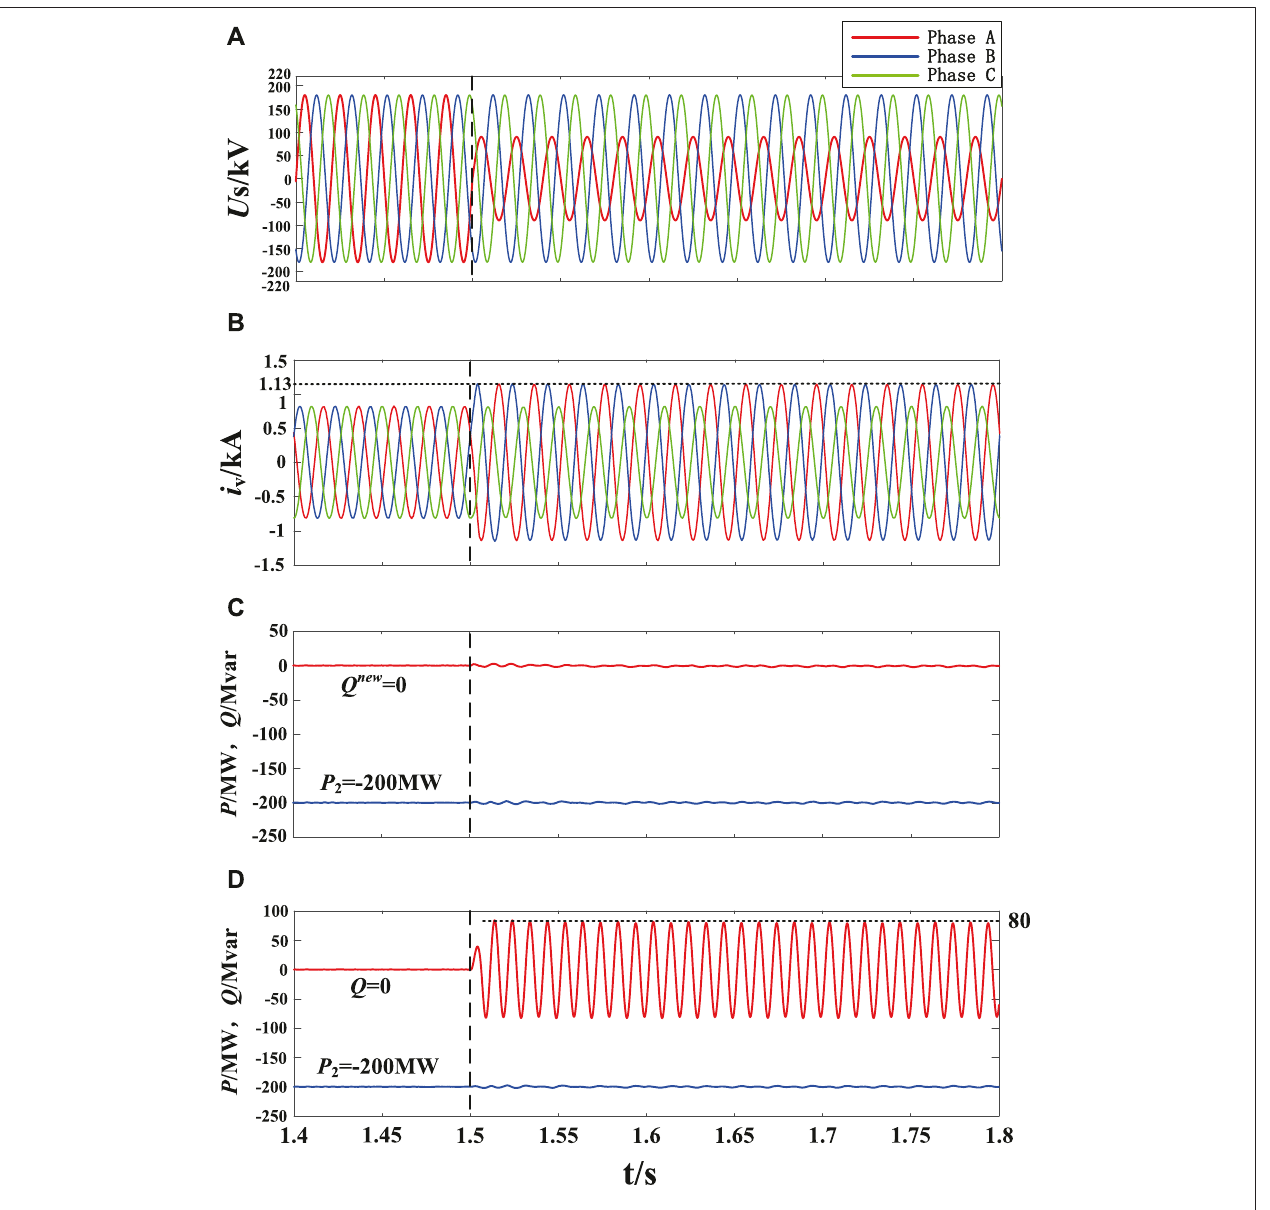
FIGURE6| ControlperformanceofthetraditionalISMVCandnovelISMVCunderunbalancedgridcondition, (A) ACgridvoltageatMMC 2 side, (B) ACgridcurrent outputbyMMC 2 , (C) active power and ERP outputbyMMC 2 using thenovel ISMVC, (D) active power and reactivepower output by MMC 2 using the traditional